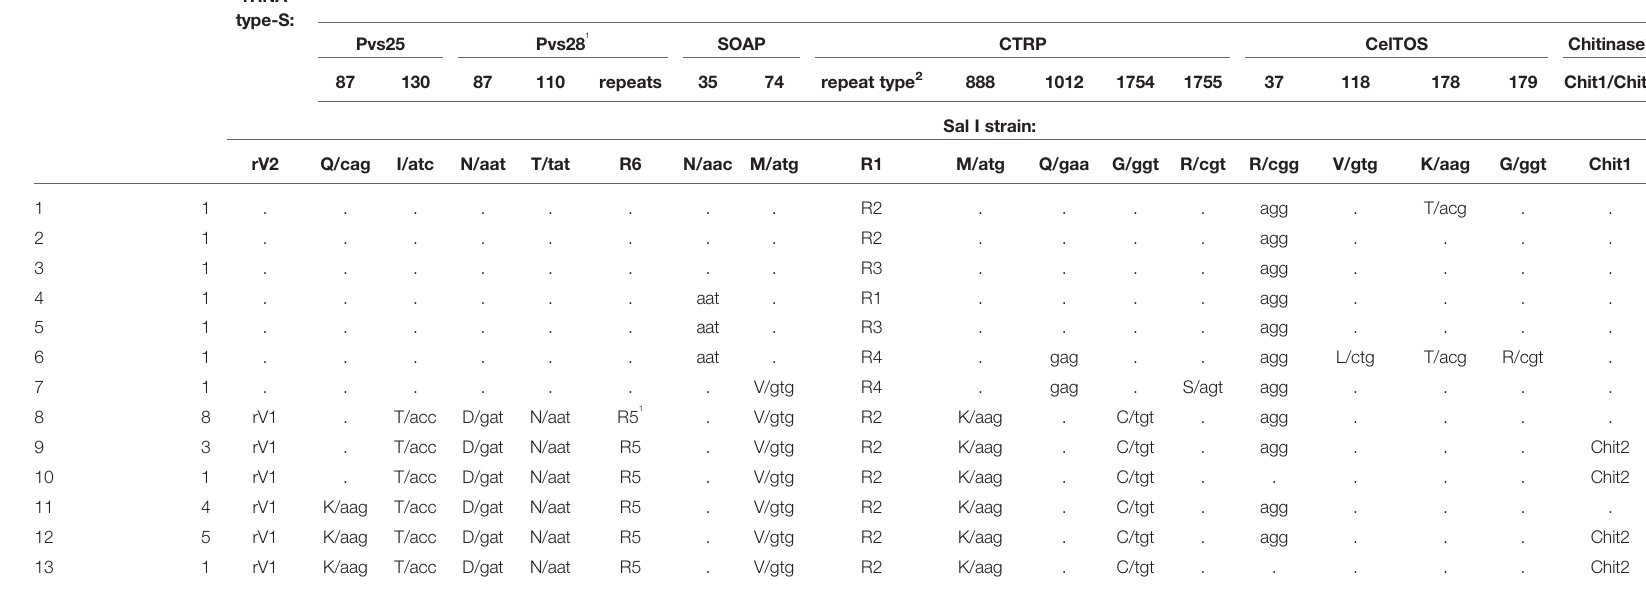
TABLE 1 | Genetic mutations and amino acid polymorphism of ookinete proteins and 18S rRNA type-S variant in 29 isolates from southern Mexico. # of